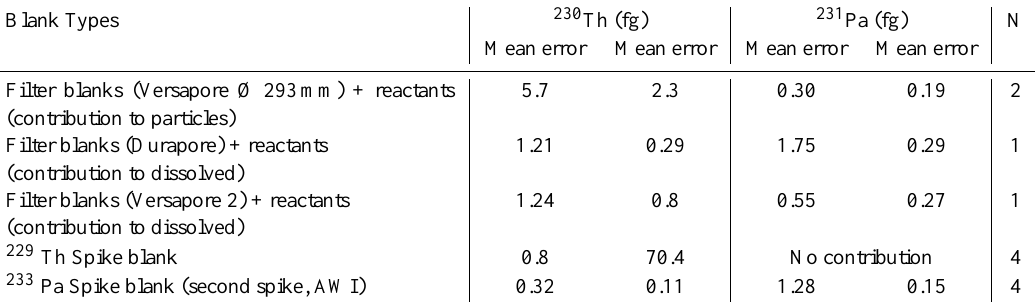
Table 2. Summary of the different chemical blank contributions to seawater and particle samples, for different types of filters and for the yield tracers 229 Th and 233 Pa used for KEOPS samples. N is the number of samples analysed. For more details, please refer to the text Sect. 2.4.3.